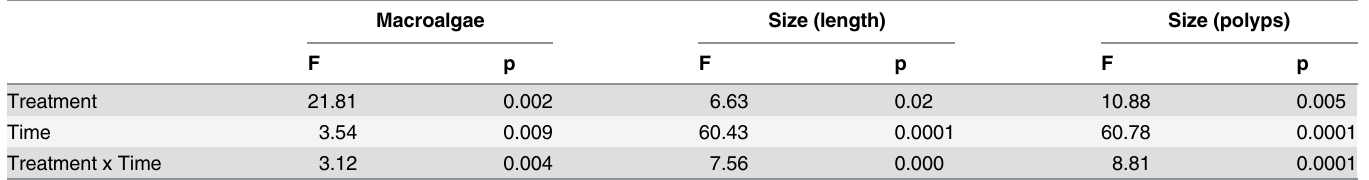
Table 1. Results of PERMANOVA and two way ANOVA ’ s comparing the volume of macroalgae and coral size in caged, uncaged cage controls in the post settlement experiment.